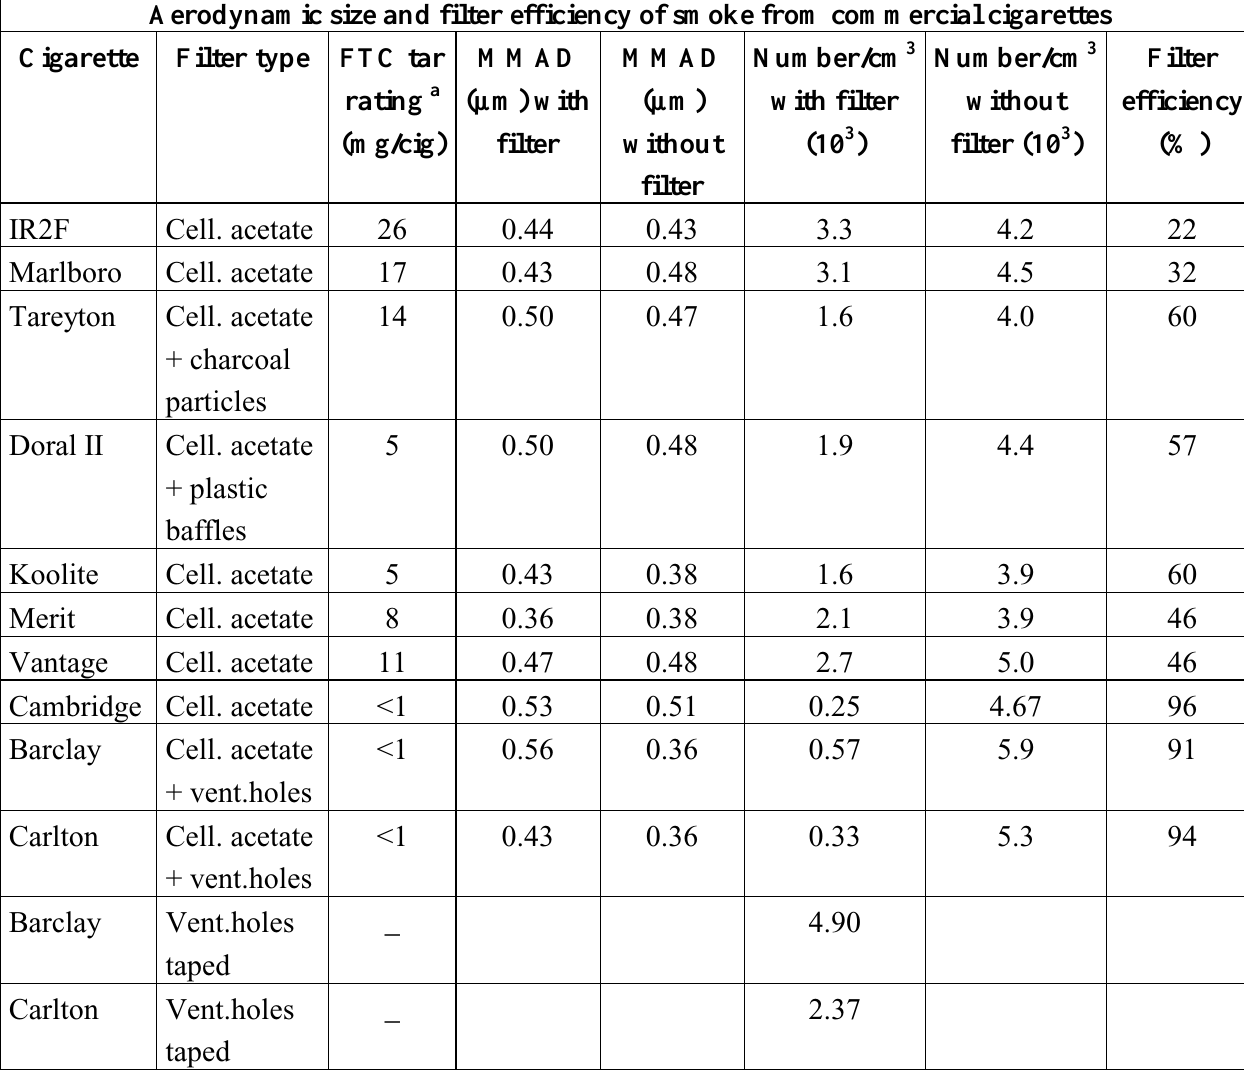
Table 2. Particles Filter Efficiency (from Bernstein/McCusker et al.